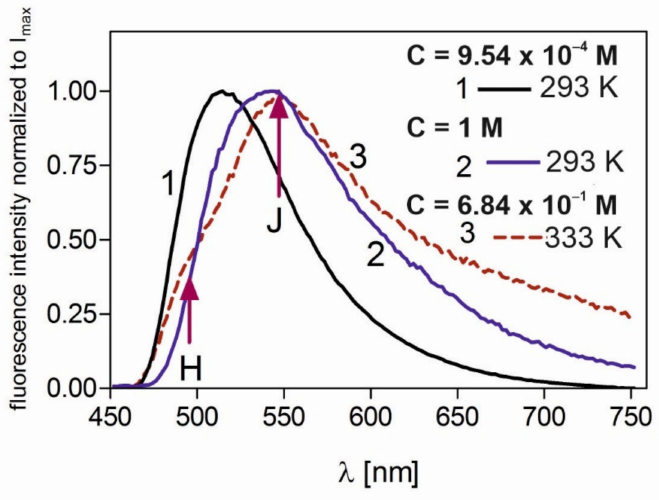
Figure 2. Fluorescence spectra of FMN: curve 1—monomer fluorescence spectrum. Curve 2— fluorescence spectrum for high concentration in T = 293 K. Curve 3—fluorescence spectrum for high concentration in T = 333 K with components of H and J dimer fluorescence bands. All spectra were reconstructed from Grajek [34] and ˙Zurkowska et al. [35]: curve 1 is based on Figure 22b from Grajek [34], curve 2 is based on Figure 2 from ˙Zurkowska et al. [35], and curve 3 is based on Figure 28c from Grajek [34] (with permission from Wydawnictwo UWM and Curr. Top.